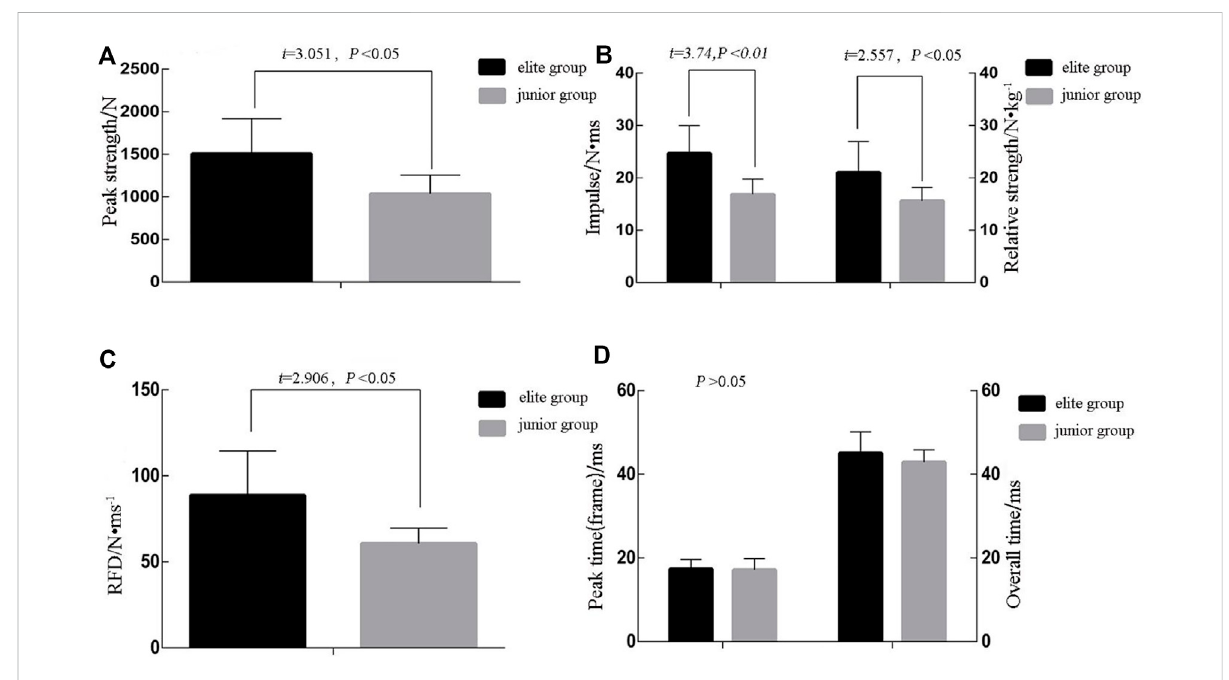
FIGURE 3 Statistical analysis of strength measuring target